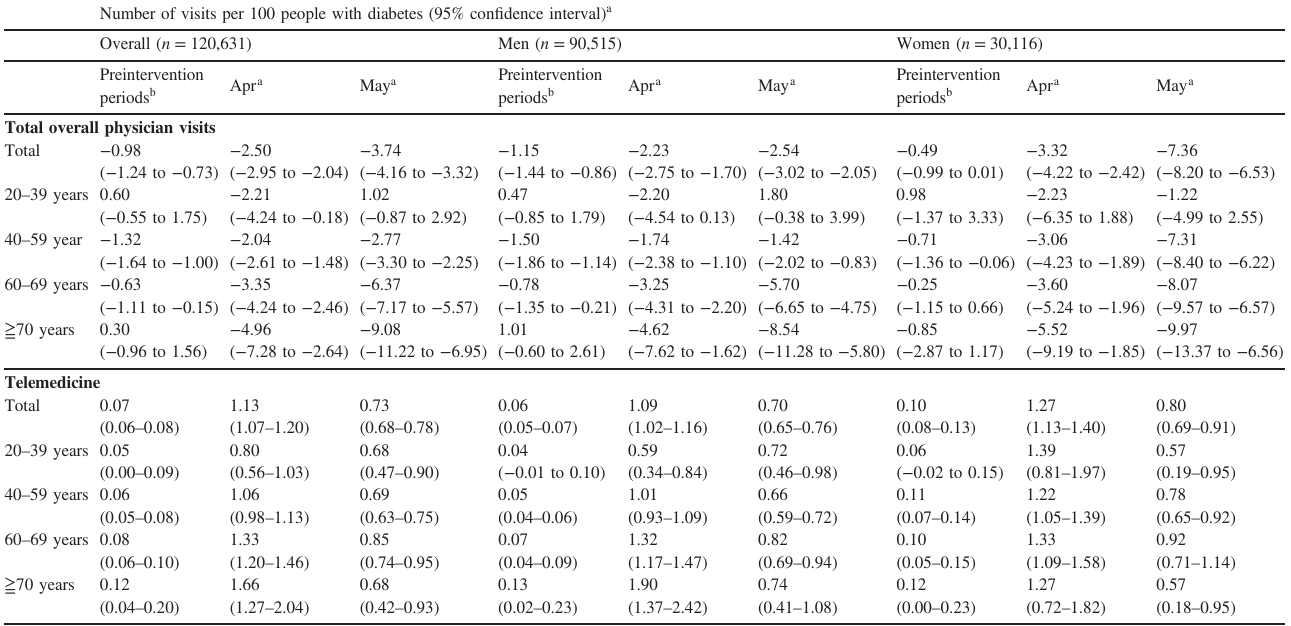
Table 3. Di ff erence-in-di ff erence model: Total and telemedicine visits 2020 vs 2019 for patients with type 2 diabetes Number of visits per 100 people with diabetes (95% con fi dence interval) a Overall ( n =